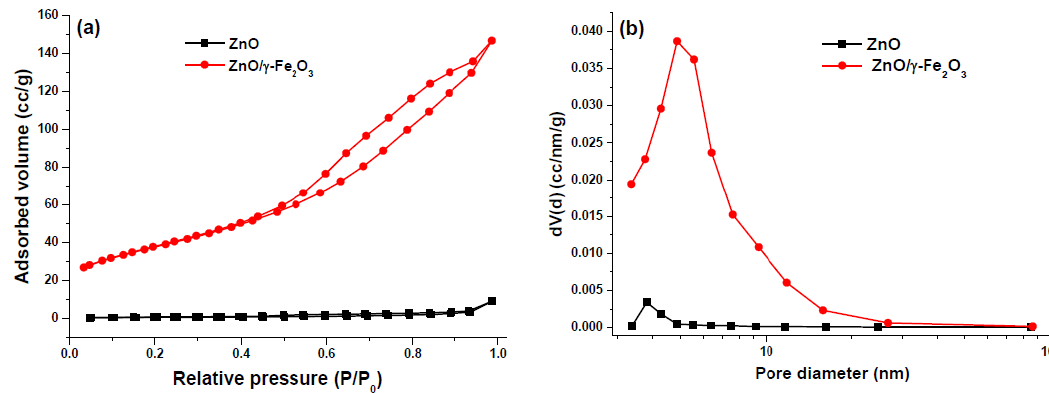
Figure 3. ( a ) N 2 adsorption−desorption isotherm of ZnO flower-like and ZnO/γ-Fe 2 O 3 nanocomposite catalysts; ( b ) Pore diameter and pore volume calculated from the desorption branch of isotherm by BJH.